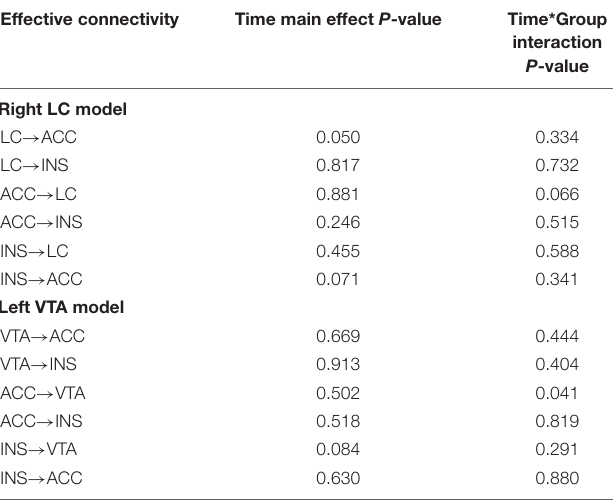
TABLE 3 | The group and time interaction in the effective connectivity. Effective connectivity Time main effect P -value Time*Group